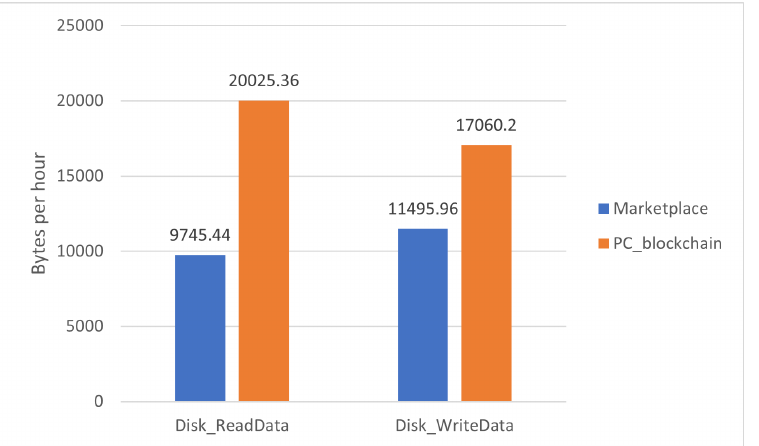
Figure 6. Comparison of disk usage metric between the proposed marketplace and an analogue blockchain over a PC.